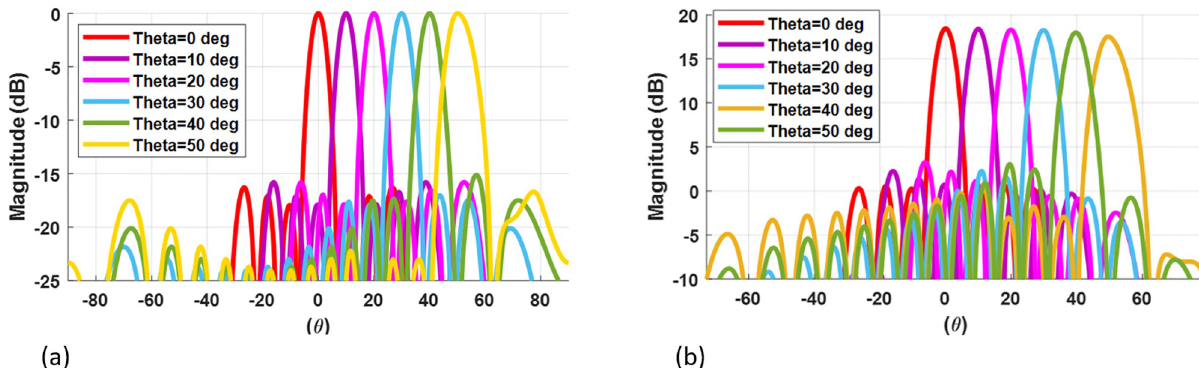
Fig 9. The simulation result of ROSA at 28GHz in a 50˚ scan sector with a 10˚ resolution demonstrates that SLL is less than -15dB (a) The array factor from numerical simulation (b) The radiation pattern from full-wave simulation.